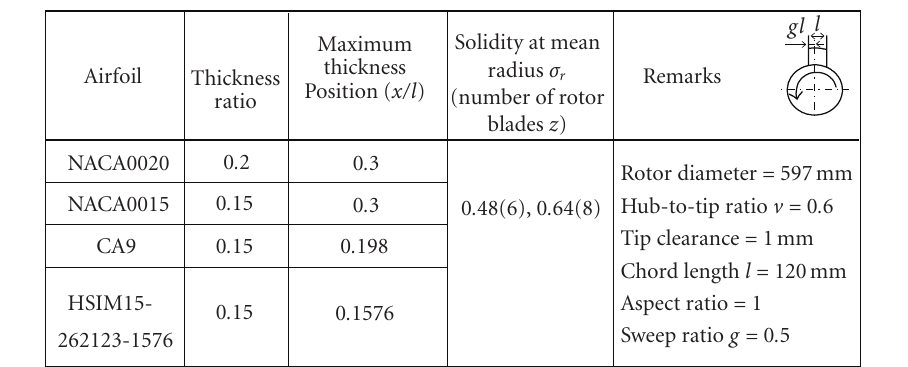
Table 1: Specification of turbines.